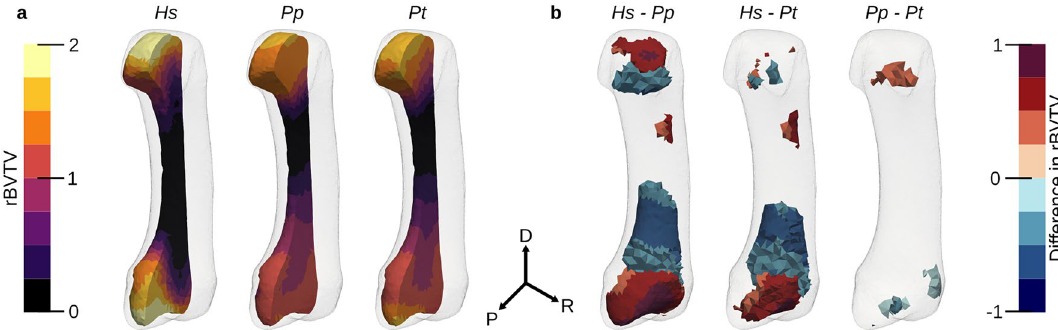
Figure 5. Average rBVTV and thresholded elements after FWER control. Average rBVTV per species cut along the sagittal plane ( a ). From left to right: Hs Homo sapiens , Pp Pan paniscus , Pt Pan troglodytes . Statistically significant groupwise differences, thresholded at critical level for α = 0.05 after FWER-control ( b ). Color gives the difference in rBVTV per species. For each pairwise comparison, a positive value (red) indicates that the first species has higher rBVTV while a negative value (blue) indicates that the second species has a higher rBVTV. D distal, P palmar, R